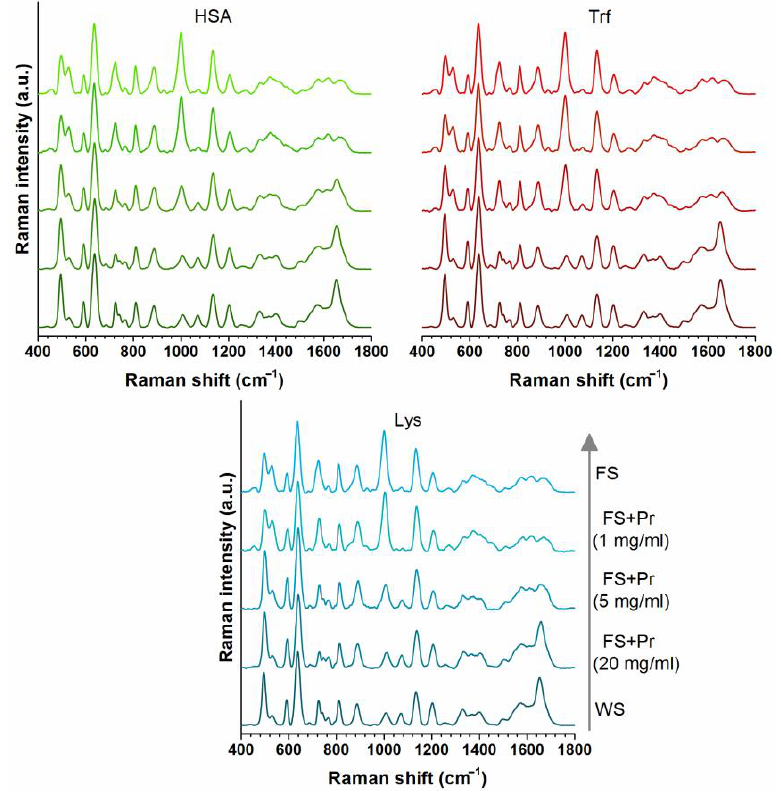
Figure 3. Changes in SERS spectra of free serum (FS) when spiked with different concentrations of HSA, Trf, and Lys. Pr denotes protein. FS + Pr (1 mg/mL) denotes free serum containing protein at 1 mg/mL concentration after mixing with AgNP colloid. Final concentration of AgNP colloid in the mixtures was 32 ×